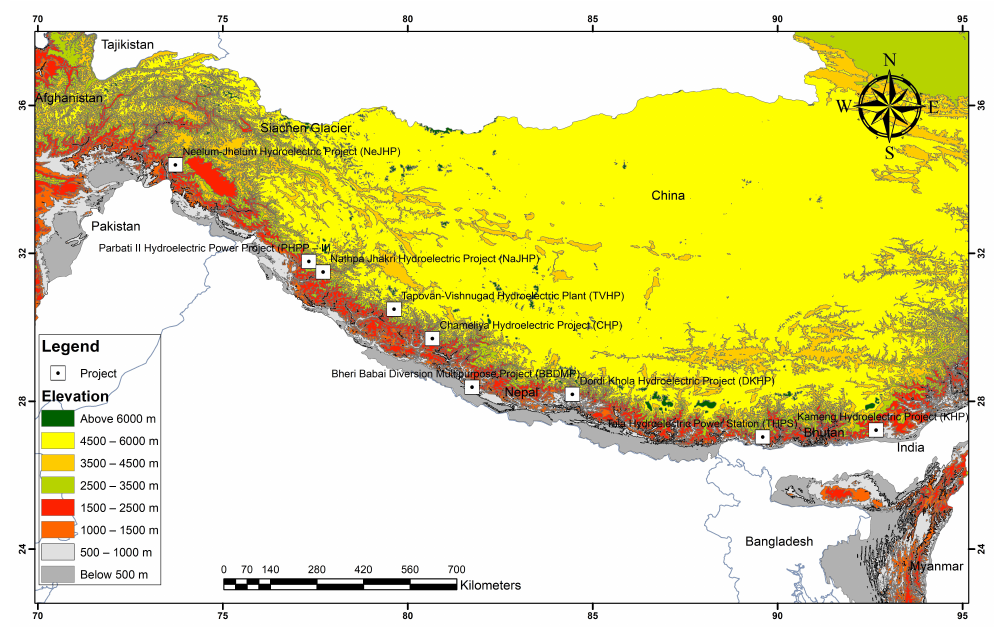
Figure 1. Project locations in the elevation map; the yellow part in the north is the Tibetan